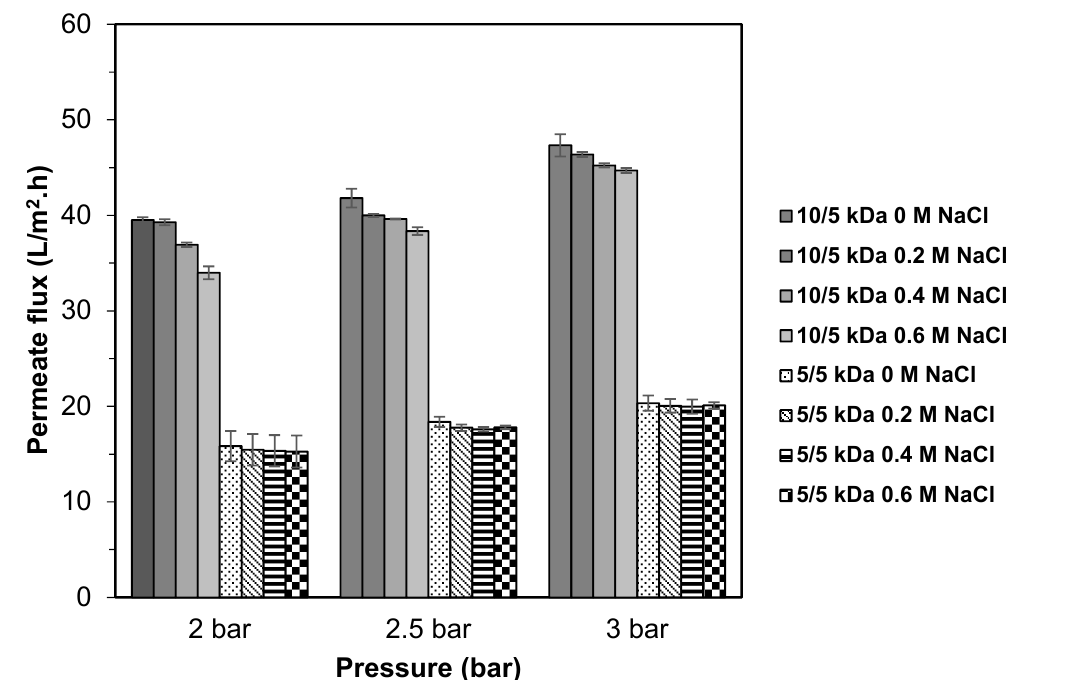
Figure 6. Permeate flux of TB protein hydrolysate using multilayer UF membranes at different salt concentration (NaCl).